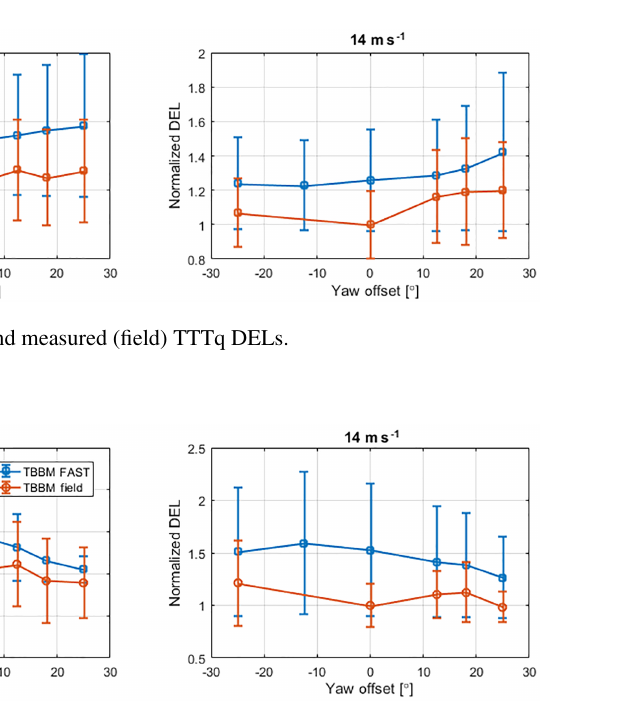
Figure A7. Comparison between predicted (FAST) and measured (field) TBBM DELs. The largest component among eight sectors was selected for each yaw